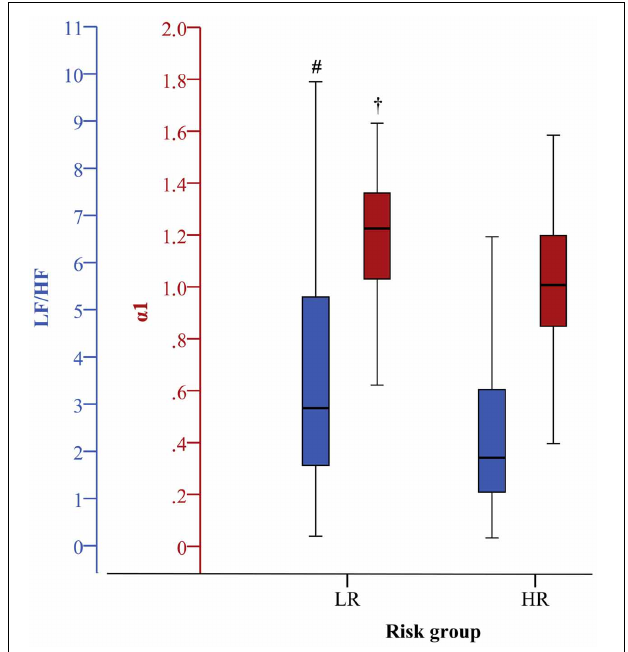
FIGURE 1 | Boxplots of the most significant univariate clinical, linear, and nonlinear indices (24h) discriminating low (LR) and high (HR) risk groups ( # p < 0 . 01; † p < 0 . 001).